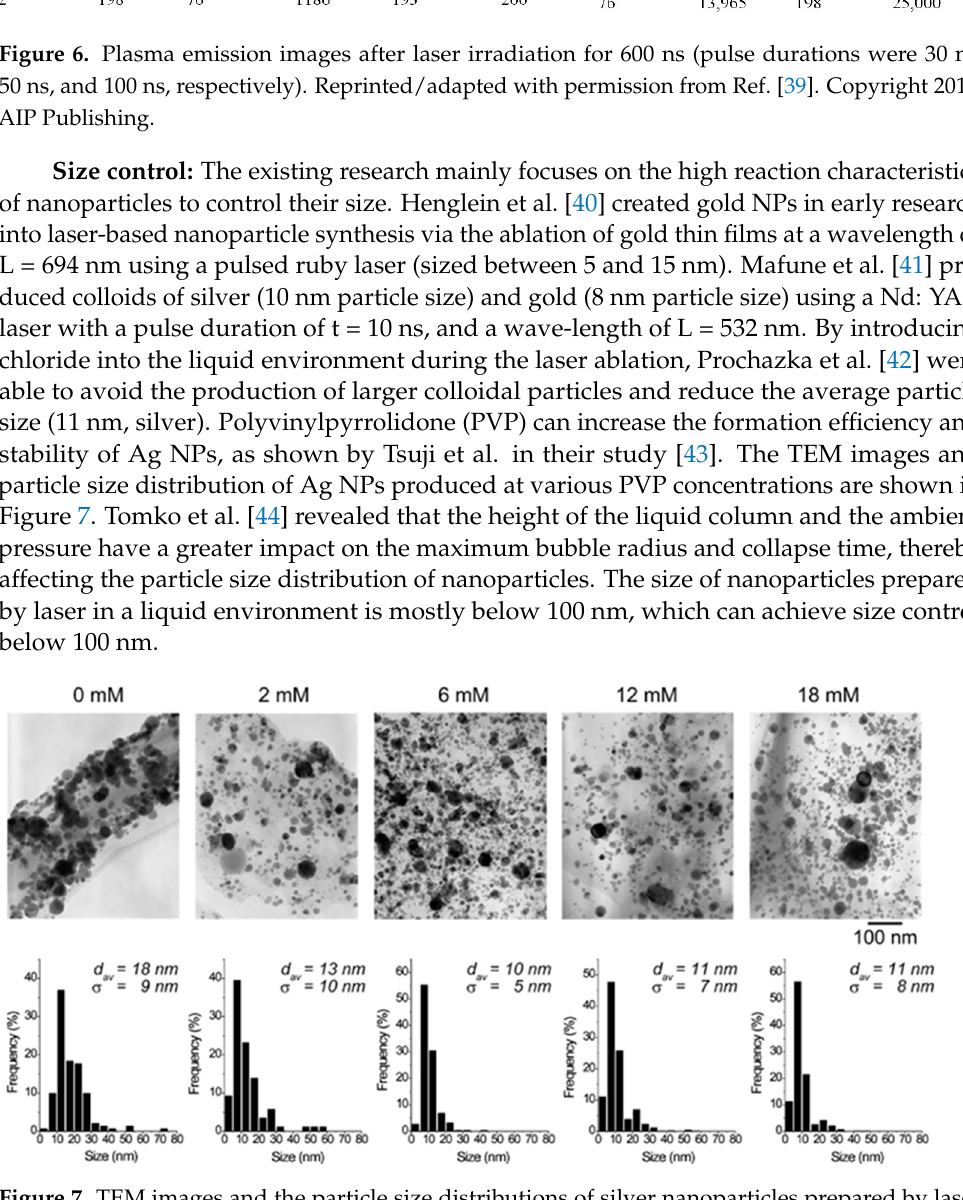
Figure 6. Plasma emission images after laser irradiation for 600 ns (pulse durations were 30 ns, 50 ns, and 100 ns, respectively). Reprinted/adapted with permission from Ref. [39]. Copyright 2015, AIP Publishing.